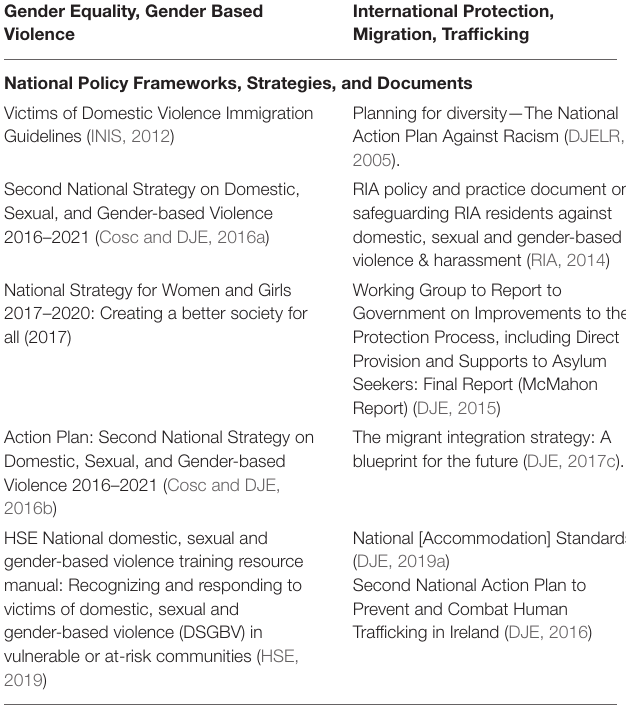
TABLE 1 | National policy documents reviewed. Gender Equality, Gender Based Violence National Policy Frameworks, Strategies, and Documents Victims of Domestic Violence Immigration Guidelines (INIS, 2012)